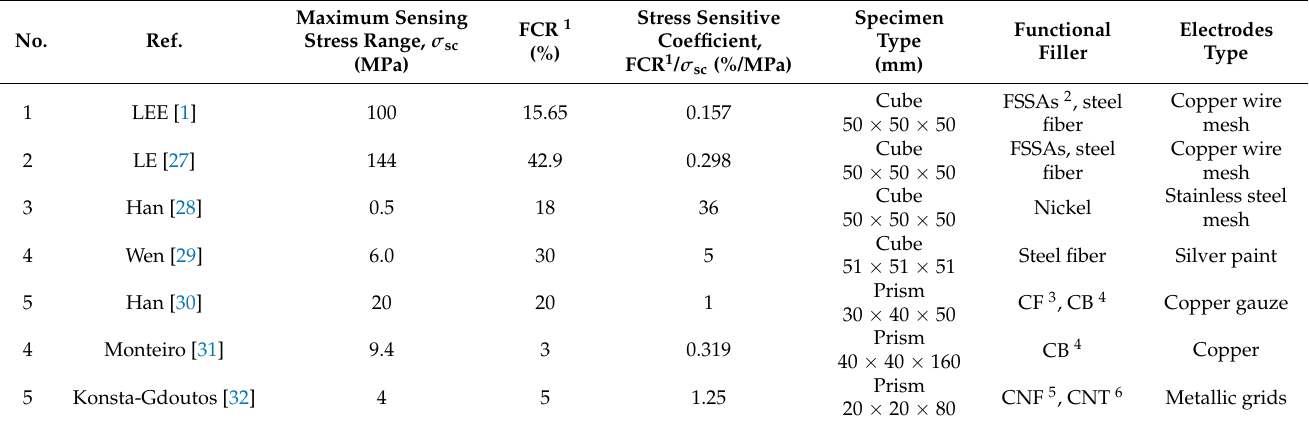
Table 1. Self-stress sensing capacity of smart concretes.